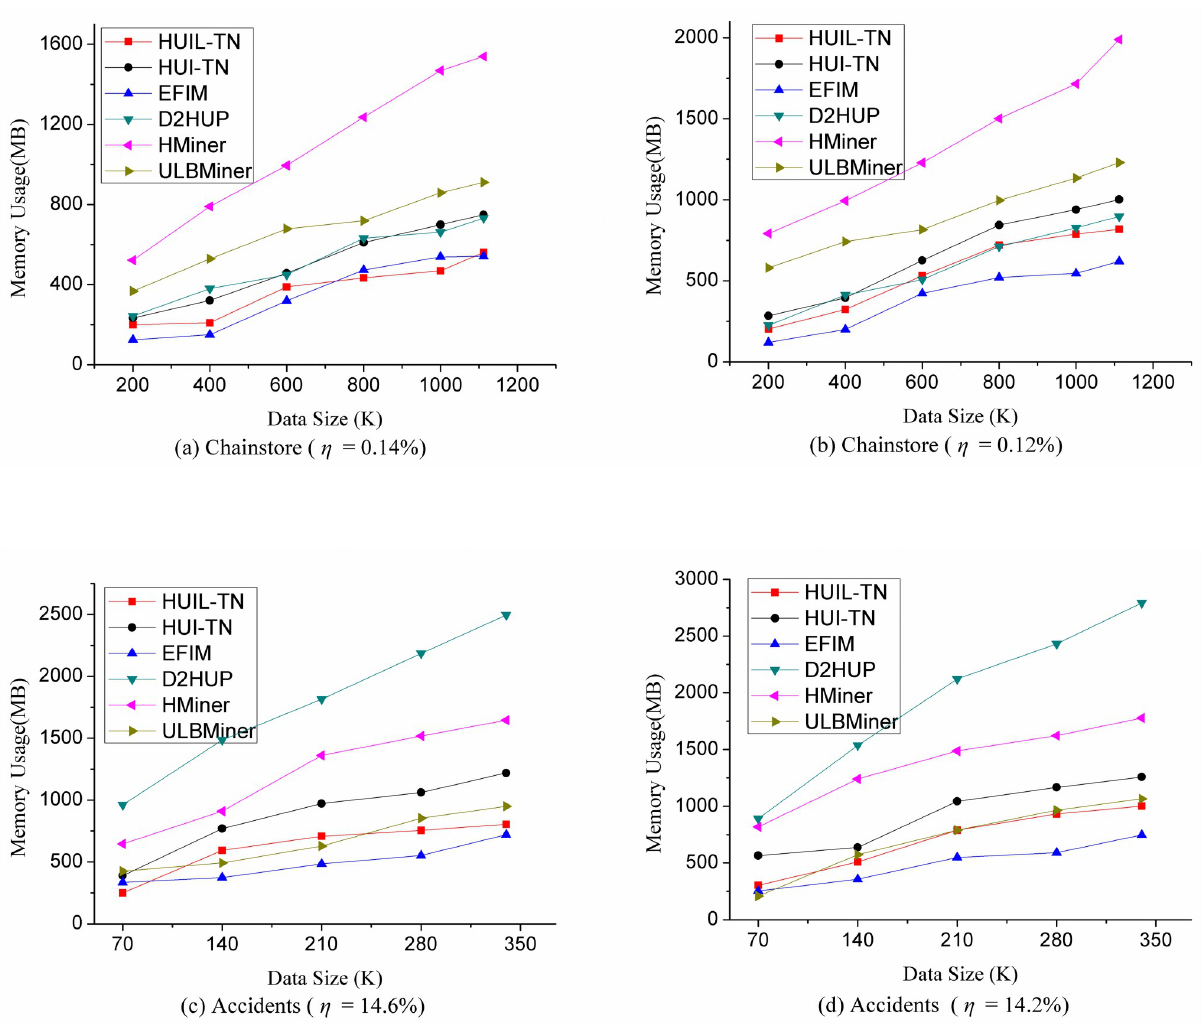
Fig 10. Comparison of memory usage under varied dataset